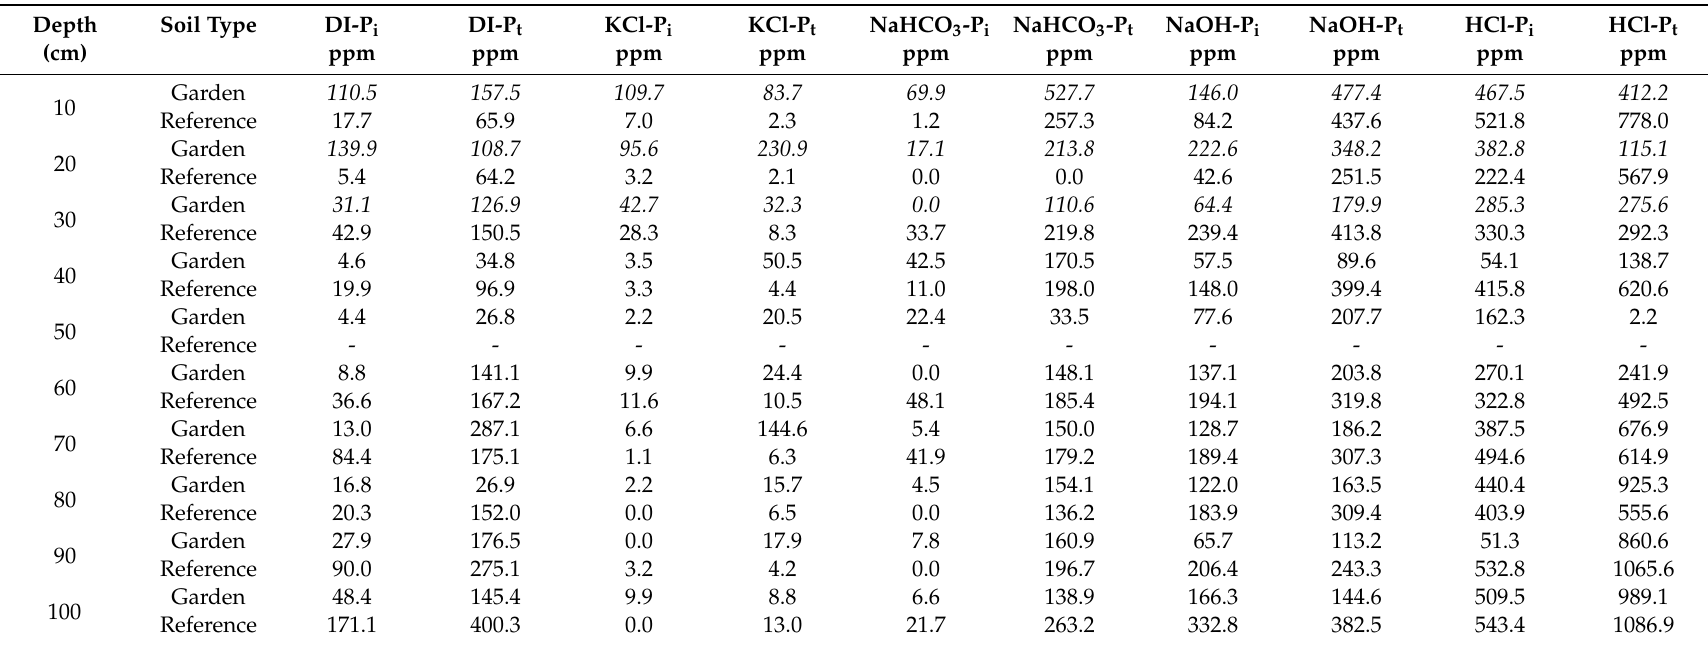
Table A1. Soil P concentrations from ten di ff erent P extractions from soil profile below one raised-bed garden established 6 years prior to testing. Depths ≤ 30 cm (italicized) were a garden soil / compost mixture; depths > 30 cm is underlying native soil. Reference soil profiles are below unfertilized